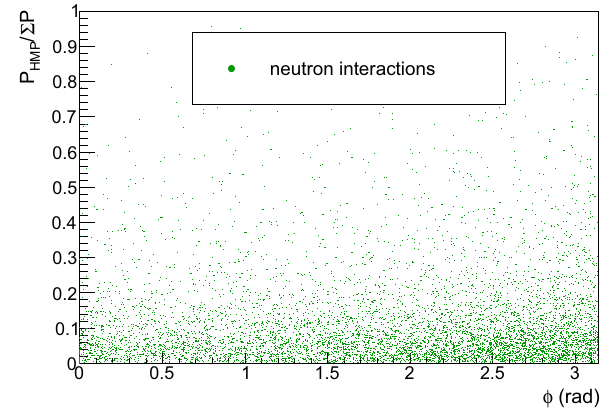
Fig. 16 Left :Distributionoftheangle φ betweentheHMPandthevec- torial sum of momenta of all tracks, in the two-dimensional transverse plane, and the momentum fraction of the HMP, for ν μ CC (blue) and